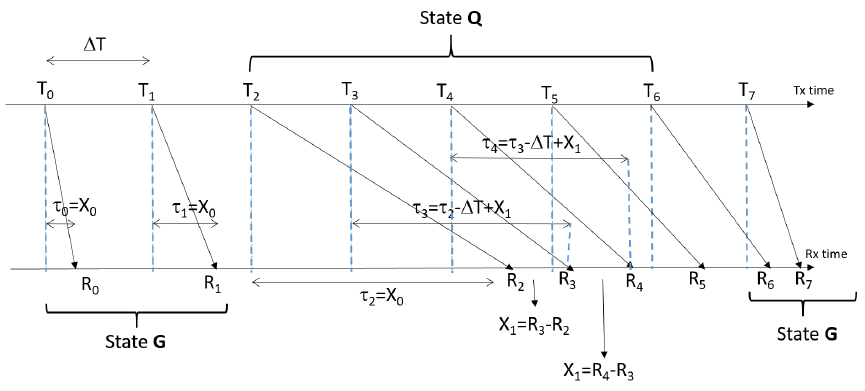
Figure 6. Time-based representation of buffering (state Q) and direct transmission (state G) conditions in the